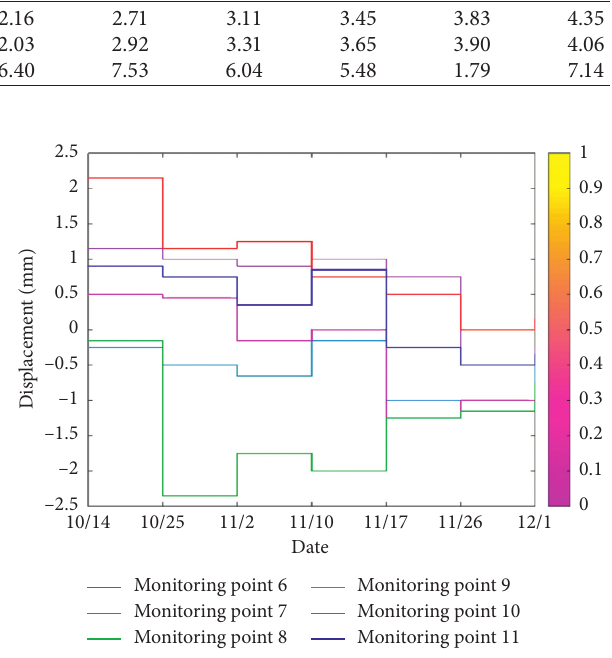
Figure 8: Surface displacement trend of monitoring points